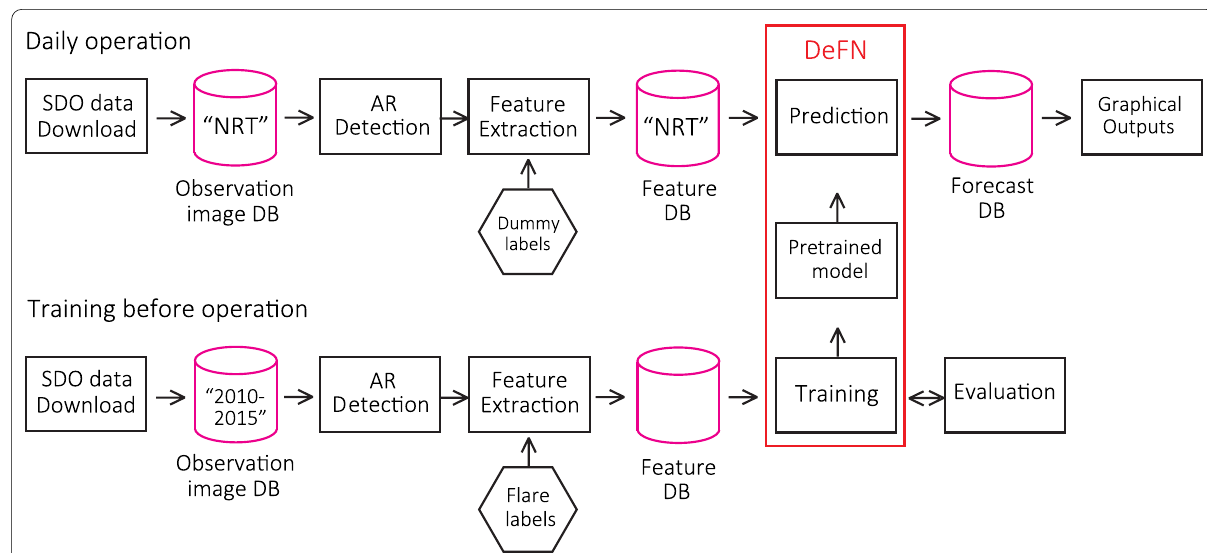
Fig. 1 Flowchart of operational DeFN. It is executed using the NRT data and the pretrained model. The best-performing model among the models trained using the 2010–2015 datasets is chosen as the pretrained